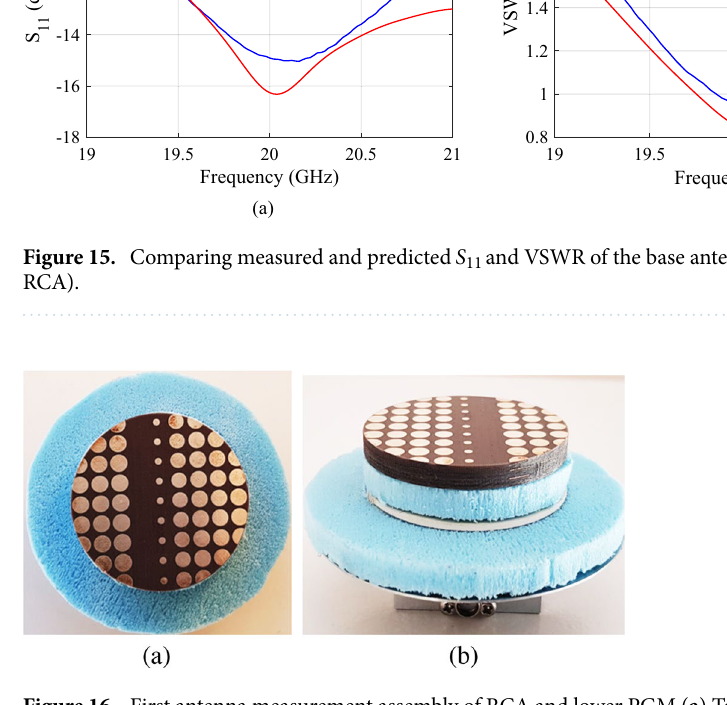
Figure 16. First antenna measurement assembly of RCA and lower PGM ( a ) Top view and ( b ) side view.